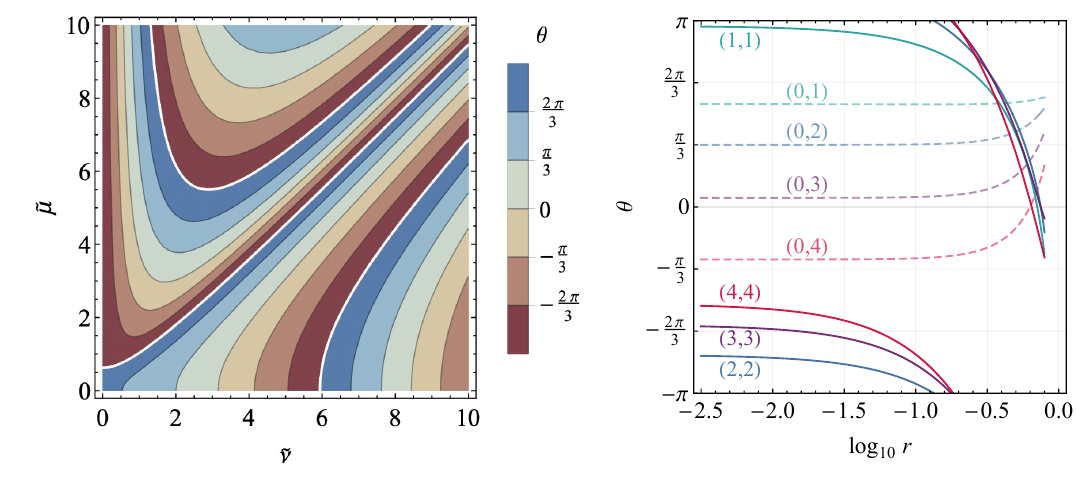
Figure 6 . The phases of nonlocal signal from a massive spin-1 boson. The left panel shows the phase in the squeezed limit r 1 = r 2 → 0 as a function of mass parameter potential µ = µ/H . The right panel shows the phases as functions of r for several choices of ( e and with k 1 = k 2 = k 3 = k 4